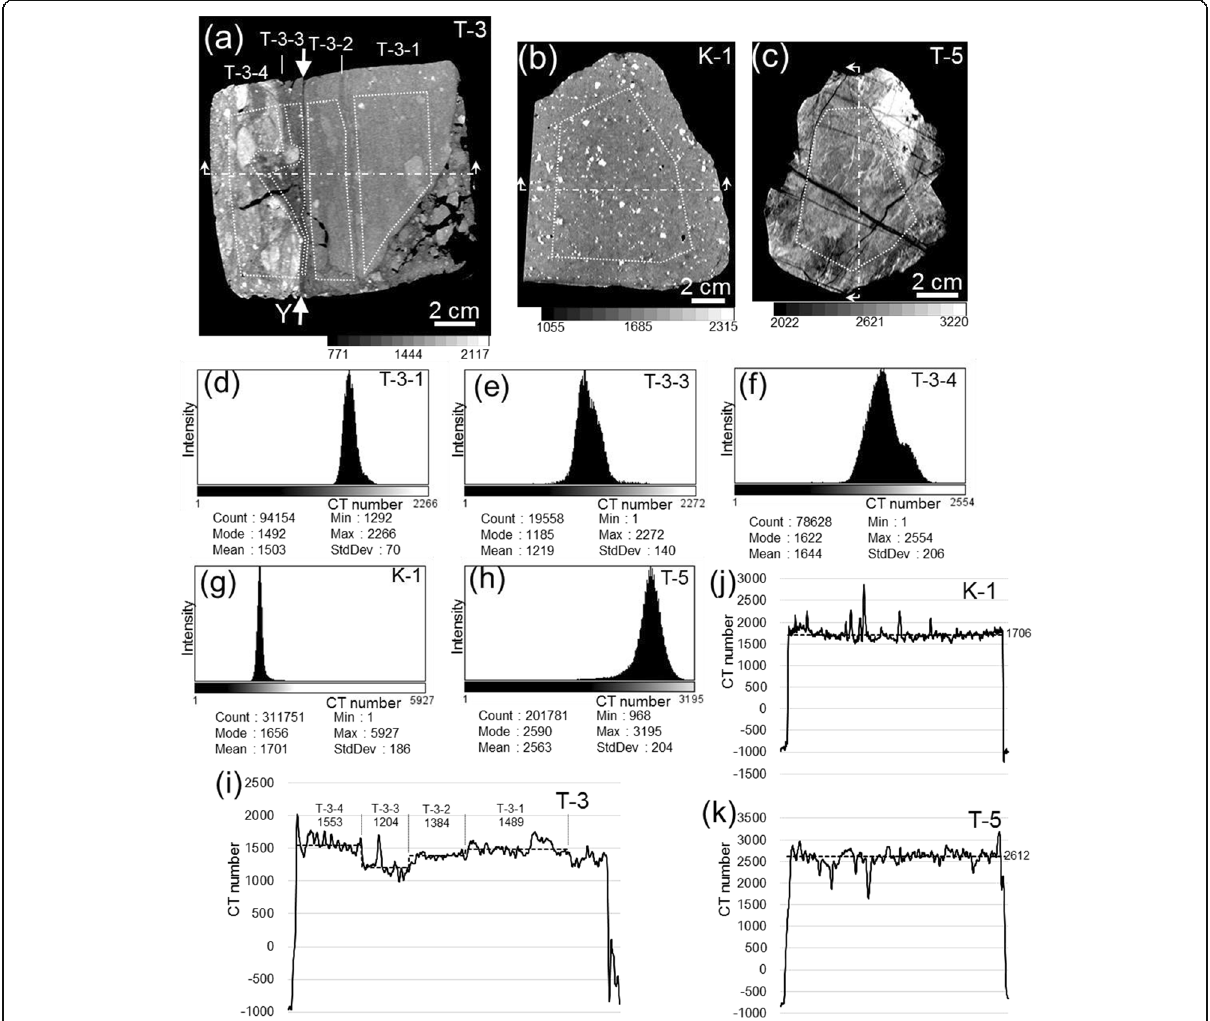
Fig. 8 X-ray CT image analysis results for the Oritodani outcrop samples. CT images of samples a T-3, b K-1, and c T-5. CT number histograms for d T-3-1, e T-3-3, f T-3-4, g K-1, and h T-5. The N CTM value in each zone was calculated near the center (within the white dotted lines in ( a ) – ( c )), with the peripheral values excluded. CT number profiles for i T-3, j K-1, and k T-5, with the values calculated along the dash-dotted lines in ( a ) – ( c ),